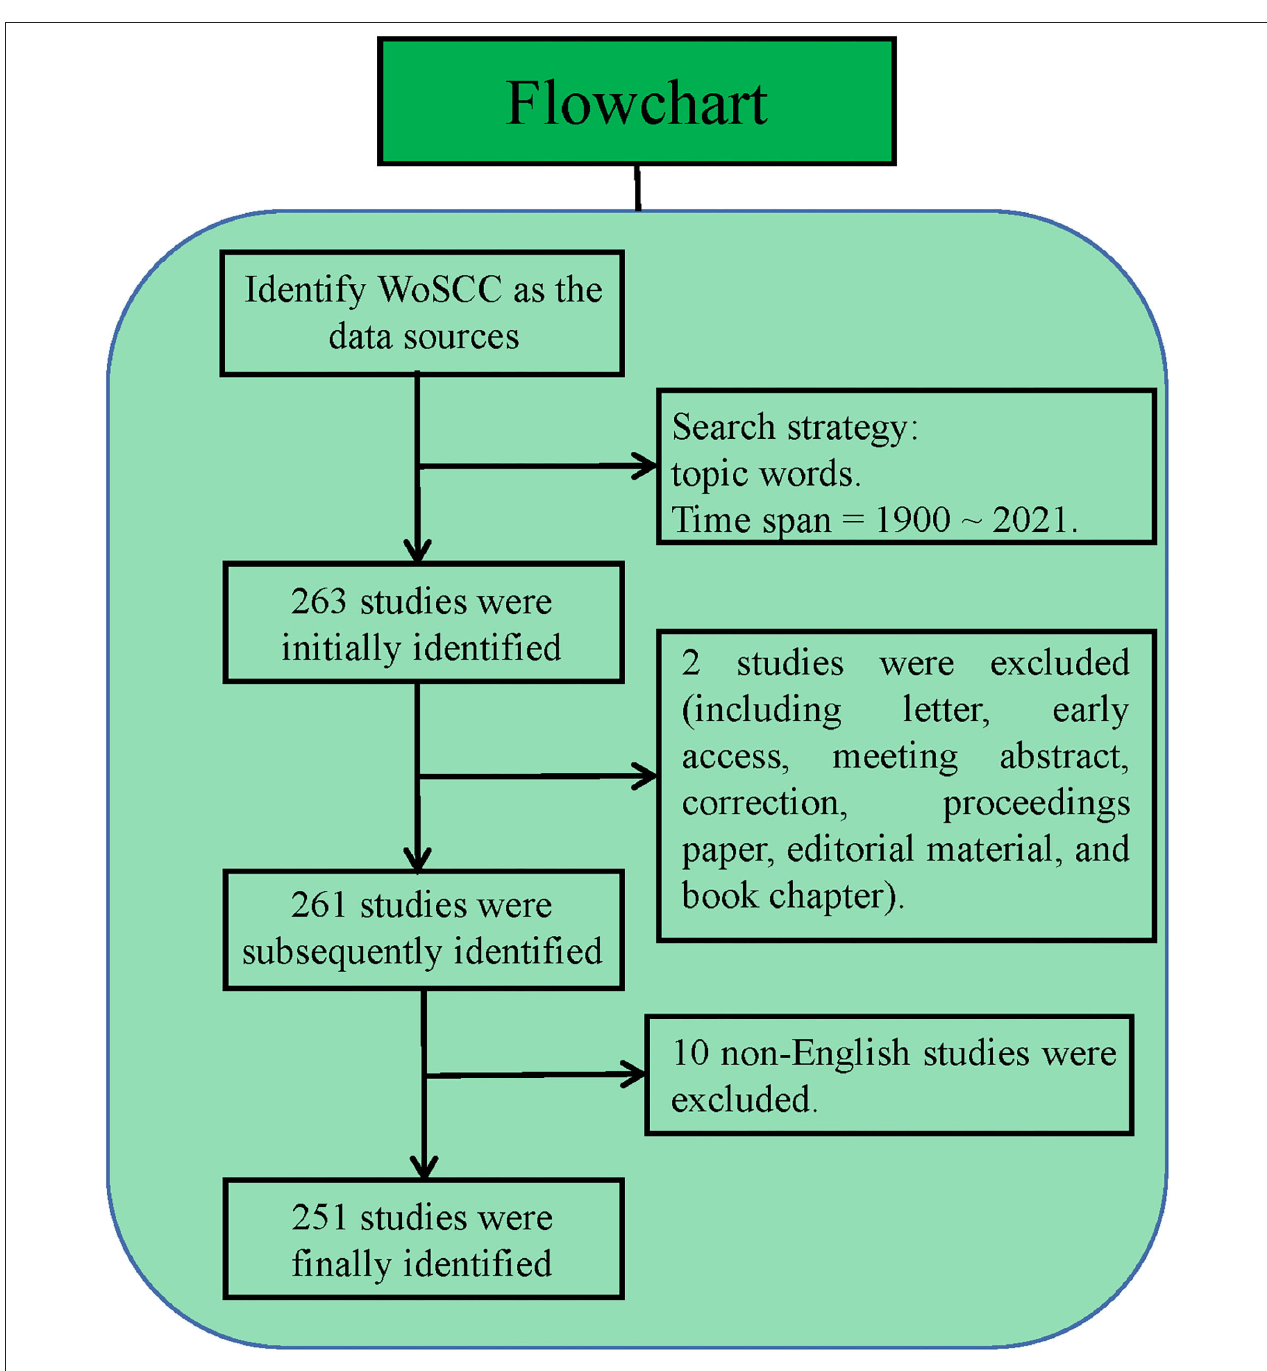
FIGURE 1 | Summary of retrieval